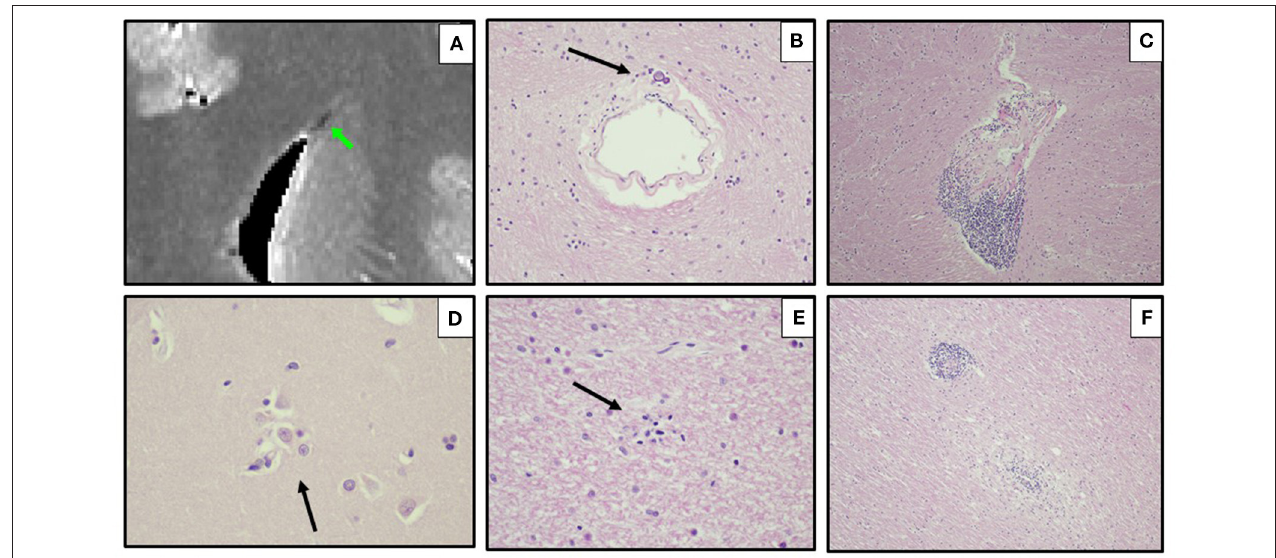
FIGURE 7 | Ex vivo MRI and autopsy neuropathology in Case 8. (A) Ex-vivo coronal T * 2 parametric map derived from multi-echo gradient-echo MRI at the cingulum, displayed in radiological orientation convention, showing a focal periventricular region of susceptibility-induced T * 2 shortening (green arrow). (B) Thickened periventricular vessel with mineralization, atypical for child of this age (H&E, 200x). (C) Internal capsule with perivascular lymphocytes (arrow) (H&E, 100x). (D) Putamen (600x), and (E) subcortical white matter (400x) with microglial nodules (arrows) (H&E). (F) Pons, caudal, with perivascular and parenchymal mononuclear inflammation (H&E